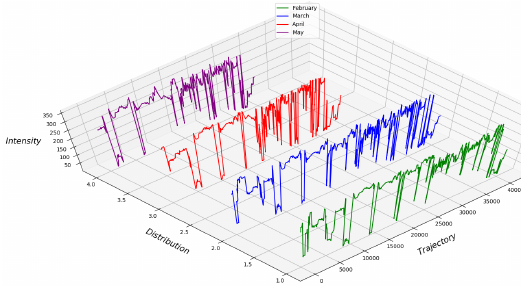
Figure 11. Measured light values for the Timis 1) segment of A1-DN7